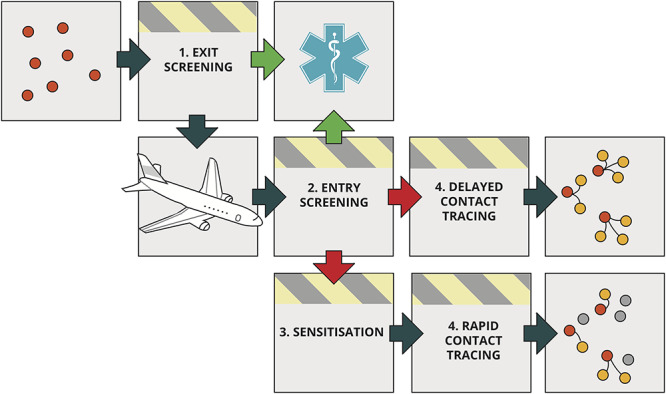
Schematic of the air traveller intervention process. A proportion of infected travellers (red dots) will be detected through syndromic exit or entry screening (green arrows) and will immediately be isolated and not cause secondary cases (yellow dots) in the as yet unaffected destination. Travellers not identified by syndromic screening enter the destination country (red arrows), where they are provided by sensitisation information and are more likely to self-isolate and/or report their symptoms soon after onset and cause fewer secondary cases (dots that are yellow under ‘delayed contact tracing’ but grey under ‘rapid contact tracing’).